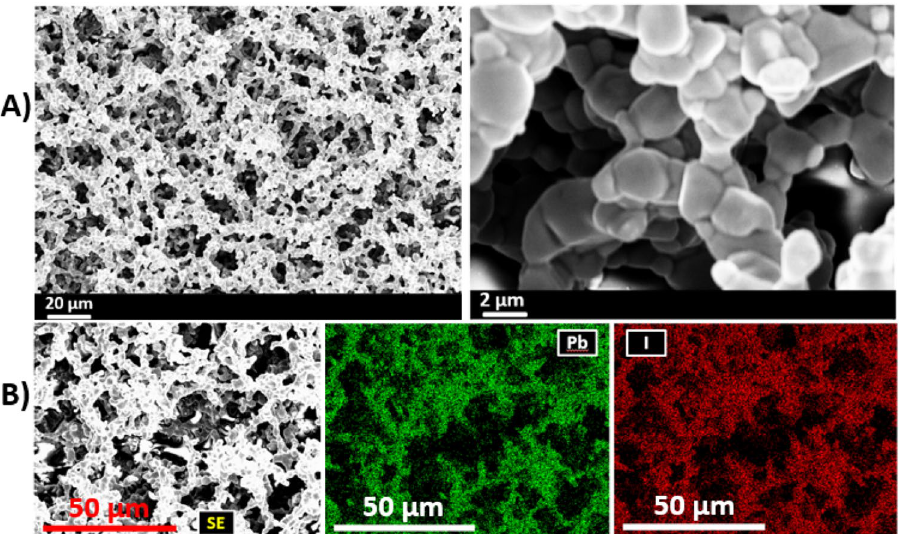
Figure 2. Investigation of surface morphology of FAPI thin films and spatial elemental distribution of Pb and I within the films. ( A ) Secondary electron SEM images taken at low and high magnifications showing gross mesoporous appearance and interconnectivity of FAPI crystallites. ( B ) EDX spectroscopic mapping of FAPI showing the distribution of the Pb and I (mapped from K alpha emission intensity) within the film in plan view. The elements are co-localised in